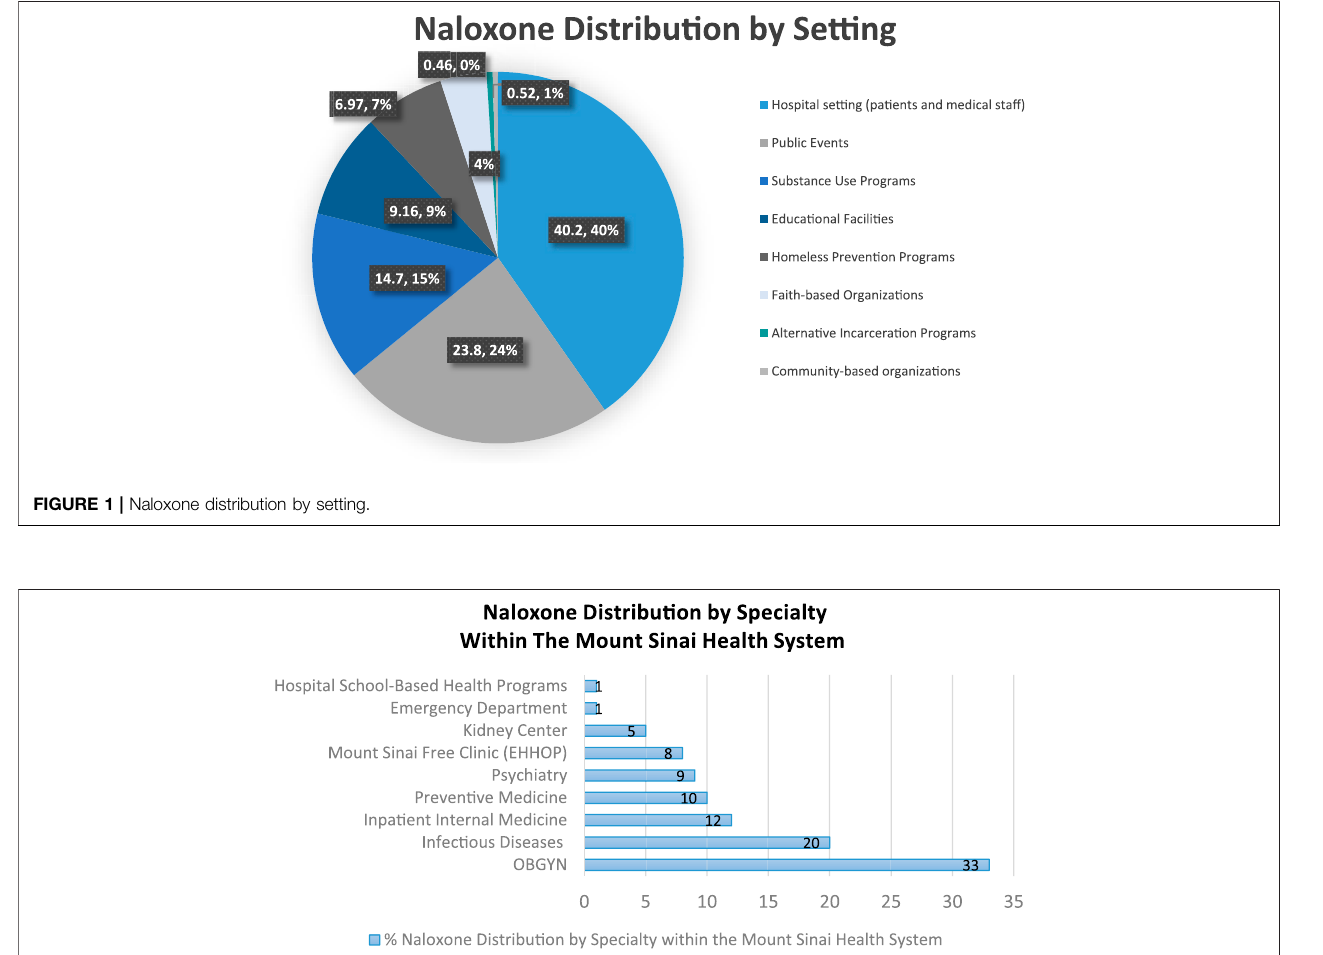
FIGURE 2 | Naloxone distribution by specialty within the Mount Sinai health